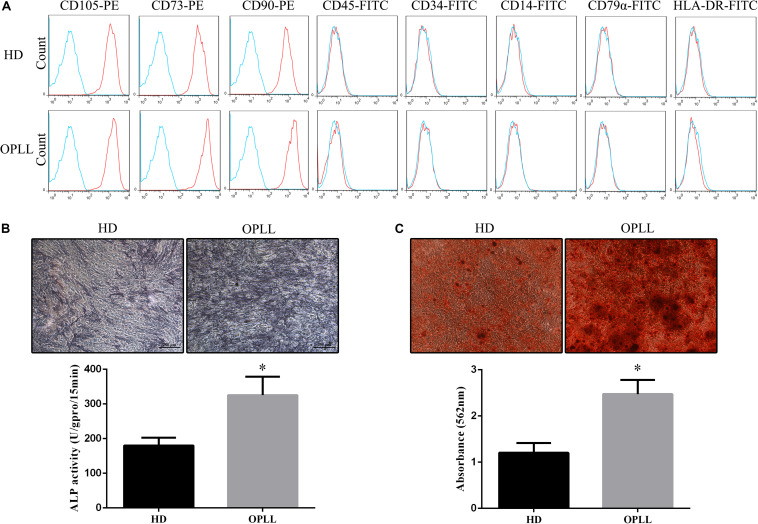
Phenotypes and osteogenic differentiation capacities of HD MSCs and OPLL MSCs. (A) Both HD MSCs and OPLL MSCs expressed typical MSC surface markers, with positivity for CD105, CD73, and CD90 and negativity for CD45, CD34, CD14, CD79a, and HLA-DR. (B) Alkaline phosphatase (ALP) assays were performed to assess the osteogenic differentiation capacity of MSCs. OPLL MSCs showed greater ALP staining than HD MSCs after 10 days of induction. The absorbance of ALP quantification of OPLL MSCs was also greater than that of HD MSCs. (C) Alizarin red S (ARS) staining assays were performed to assess the osteogenic differentiation capacity of MSCs. OPLL MSCs showed greater ARS staining than HD MSCs after 14 days of induction. The absorbance of ARS quantification of OPLL MSCs was also greater than that of HD MSCs. n = 15. ∗p < 0.05. HD MSC: mesenchymal stem cells from healthy donors; OPLL MSC: MSCs from patients with ossification of the posterior longitudinal ligament.